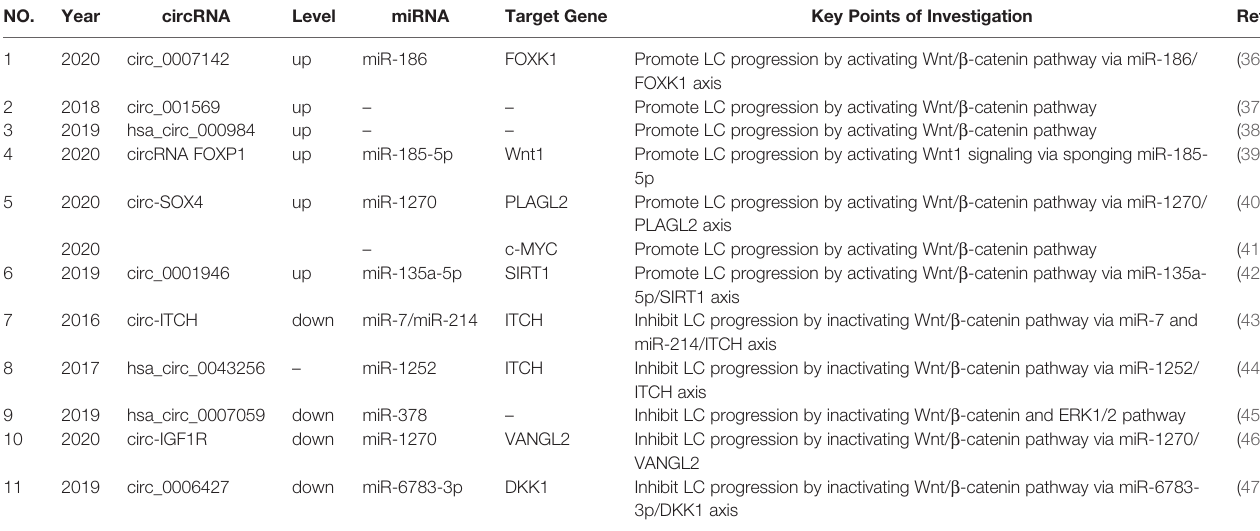
TABLE 1 | The circRNAs regulate lung cancer proliferation, migration and invasion via Wnt/ b -catenin pathway.